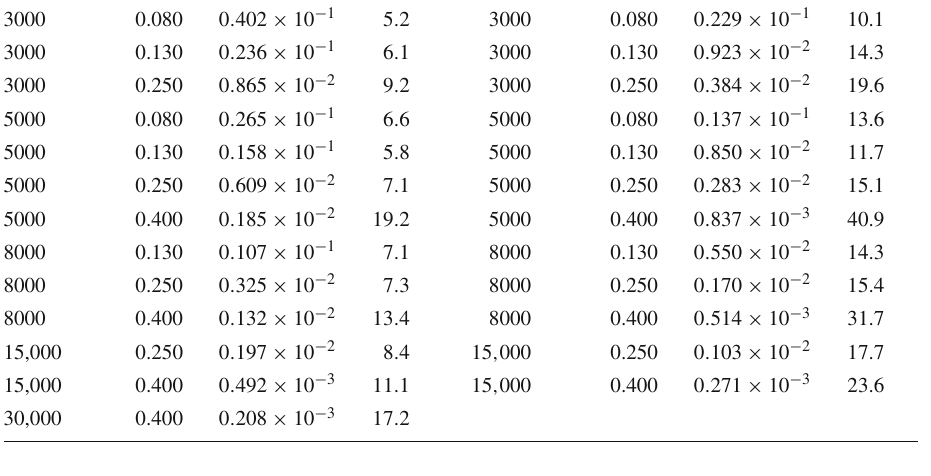
section σ = d 2 σ CC / dxdQ 2 for lepton polarisation P e = − 37 . 0% (left) and P e = 32 . 5% (right) with their statistical ( δ stat ) uncertainties. The full uncertainties are available in Ref. [58], while the respective cross section values are updated according to Sect. 3 and Ref.